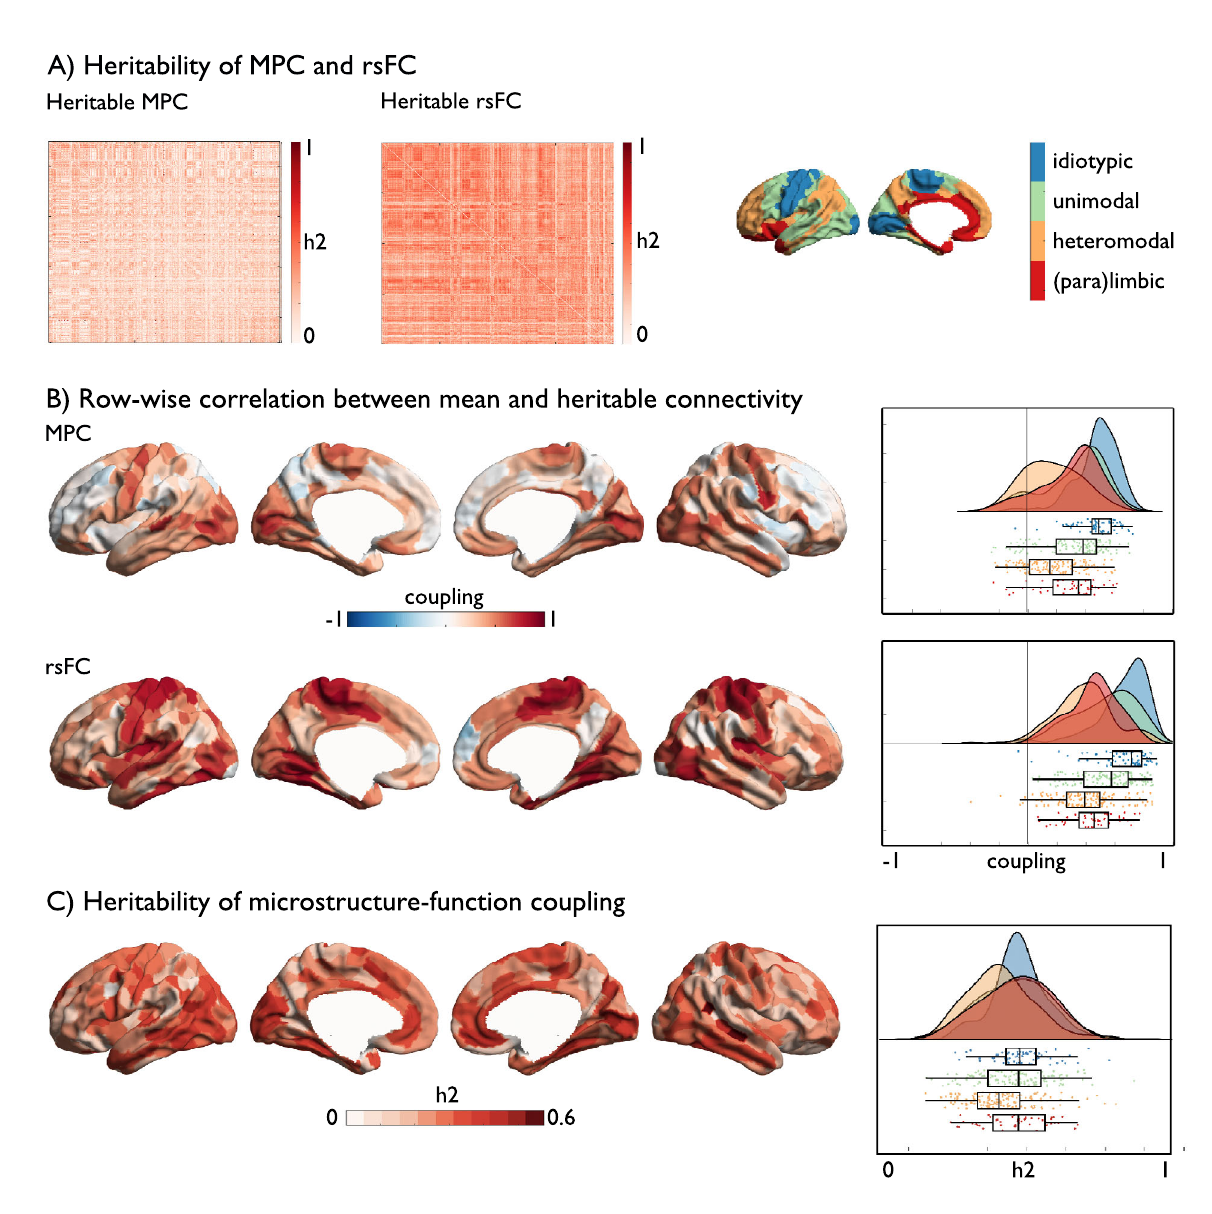
Fig. 2 Genetic basis of structure – function coupling. A Heritability of MPC and rsFC; B Row-wise association between mean and heritable seed-wise connectivity — re fl ecting genetic control over connectivity pro fi les, Right: distribution of coupling in 400 parcels per cytoarchitectural class, box shows the median and interquartile (25 – 75%) range, whiskers depict the 1.5*IQR from the quartile; C Heritability of microstructure-function coupling, Right: distribution of heritability in 400 parcels per cytoarchitectural class, box as in B 22,59 . Source data are provided as a Source Data fi Organizational differences in microstructure and functional between MPC and rsFC, we evaluated the differences in main organizational axes of MPC/rsFC. Applying non-linear dimen- sionality reduction techniques to both modalities separately 62,63 , we observed that both MPC and rsFC followed similar spatial axes as their heritability (Fig. 5). Next, we calculated the nodal difference between standardized and aligned MPC and rsFC principal gradients ( Δ MPC-rsFCG1 ). In line with previous reports 22 , gradients were uncoupled in heteromodal regions ( t = – 3.878,